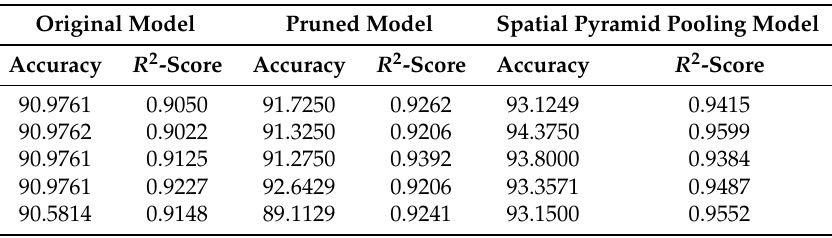
Table 7. Advanced performance of the proposed deep convolutional neural network models. Each model’s performance is based on 4000 random sample input; initialized 5 times for randomness in each epoch.